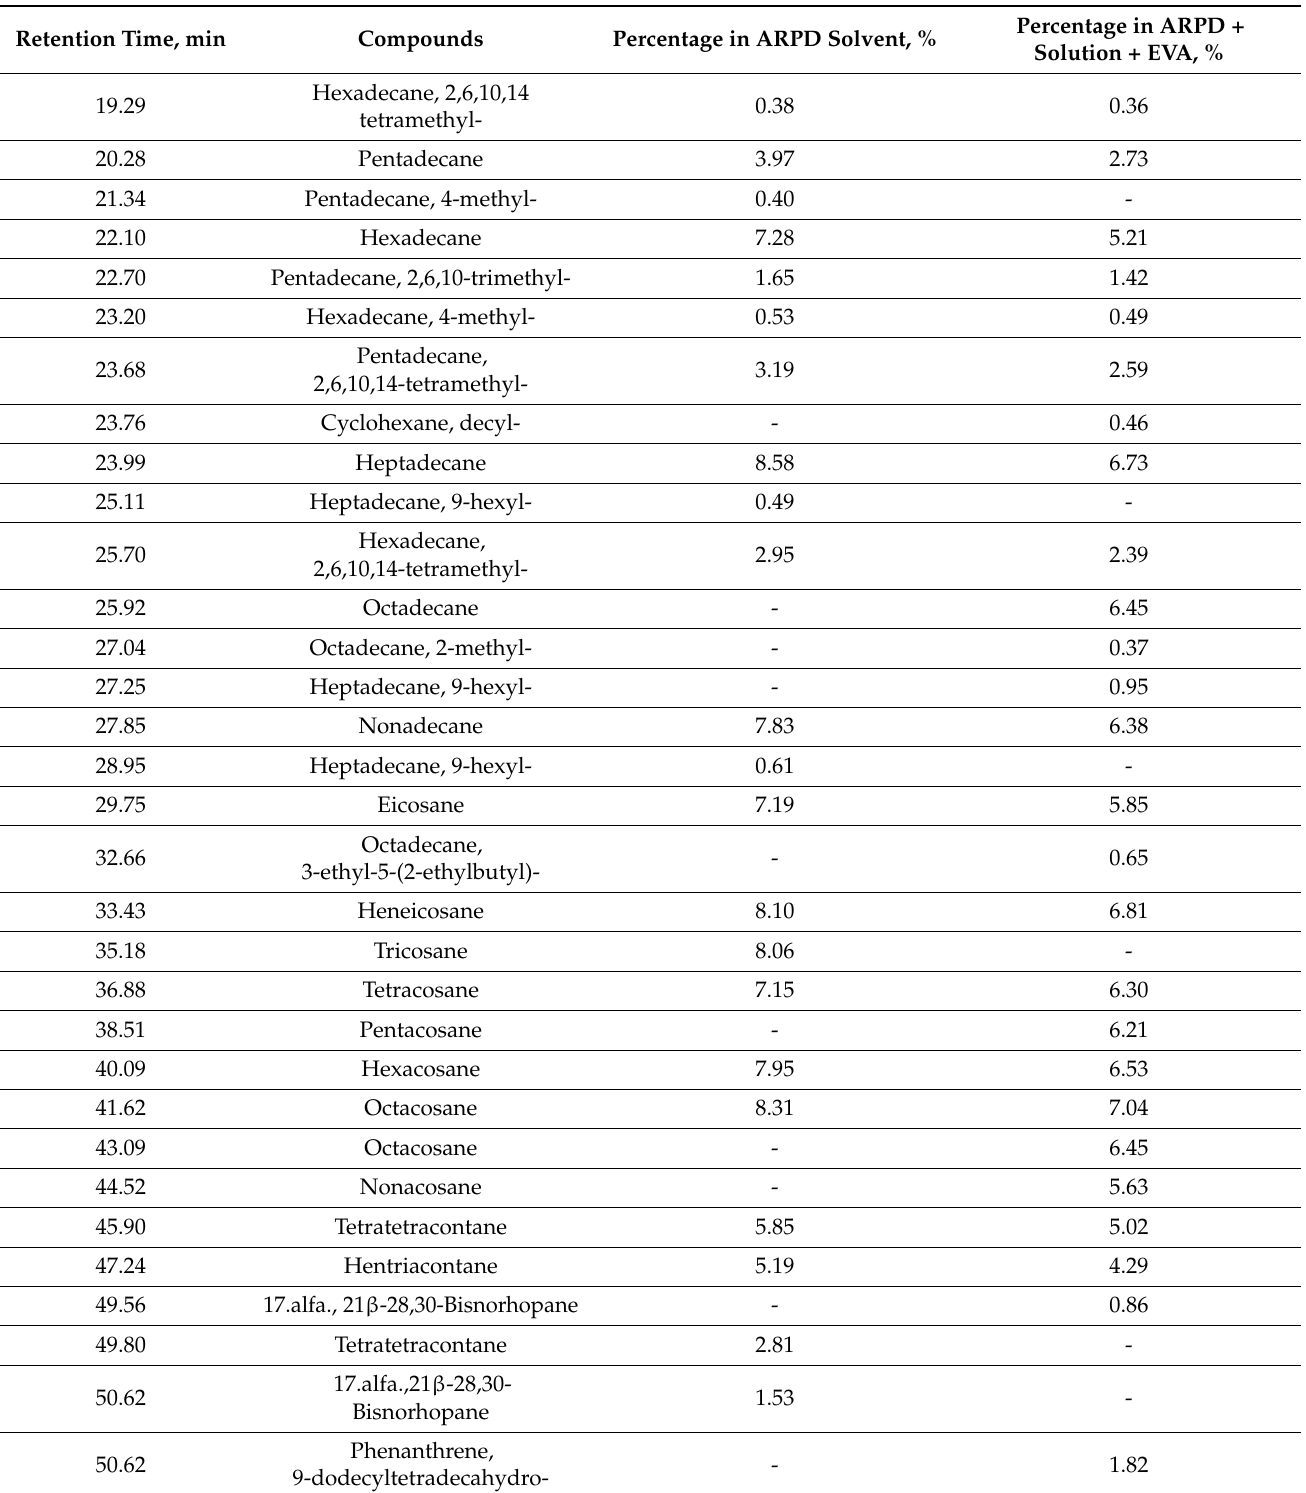
Table 3. Results of chromatographic analysis of